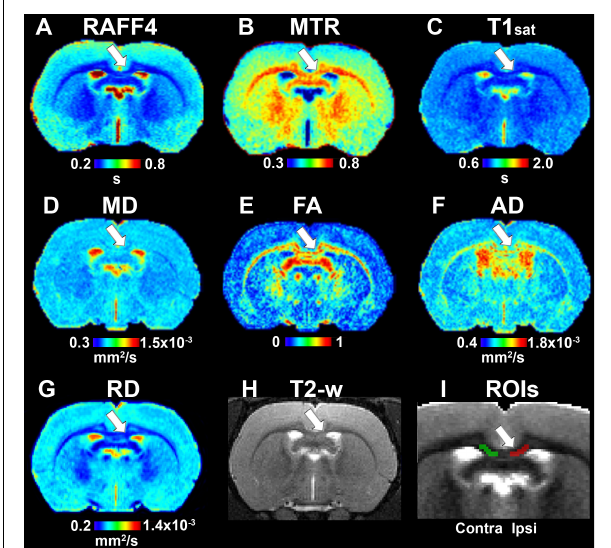
FIGURE 4 | Quantitative MRI maps in the remyelination phase, on day 38. Relaxation time constant map of RAFF4 (A) , magnetization transfer ratio, MTR (B) , T1sat (C) , mean diffusivity, MD (D) , fractional anisotropy, FA (E) , axial diffusivity, AD (F) , radial diffusivity, RD (G) , T2w image with the lesion (H) and a representative example of ROIs for analyzing lesion on a grayscale RAFF4 map (I) . White arrow points to the lesion in the corpus callosum.